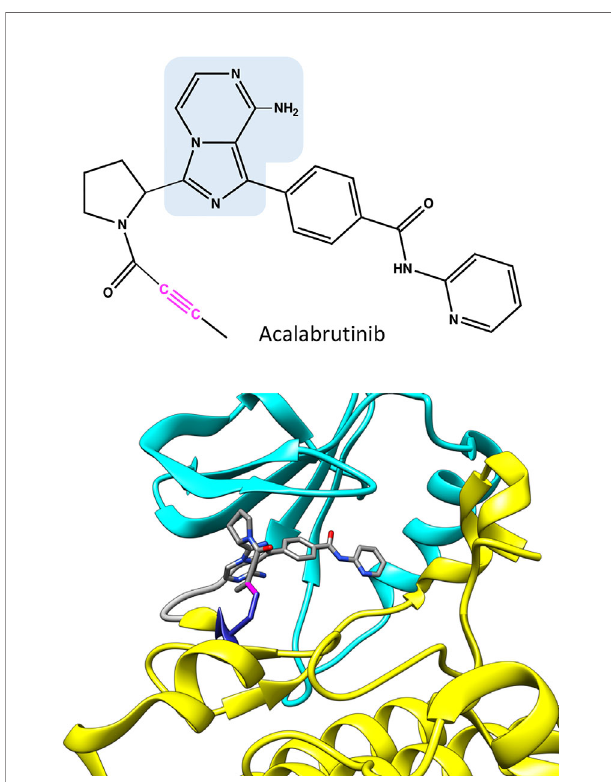
FIGURE 4 | Chemical structure of acalabrutinib and molecular model showing binding of the covalent inhibitor in BTK. Atoms in the inhibitor are colored based on the elements, carbon gray, nitrogen blue, and oxygen red. Covalent bond between C481 and inhibitor is in magenta. The structure has the same pose as in Figure 2C